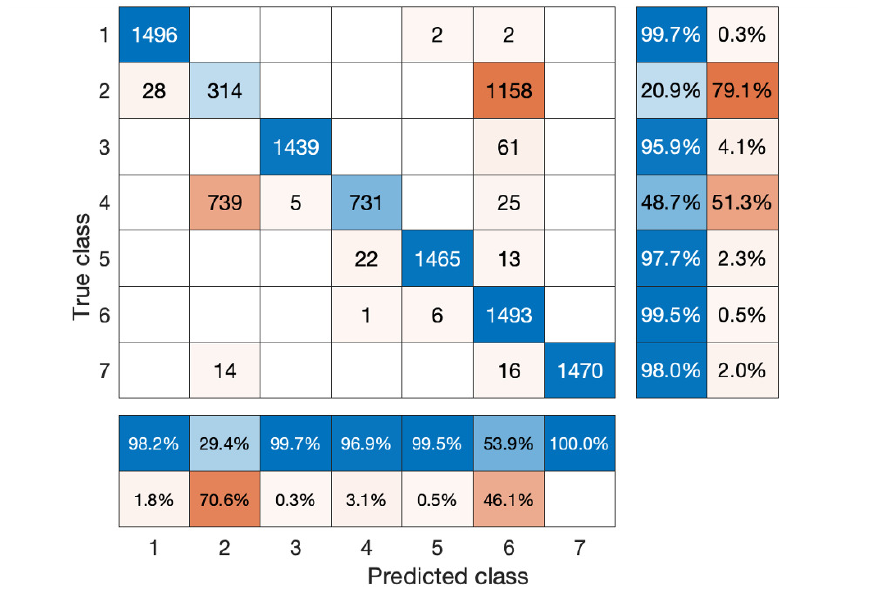
Figure 12. Confusion matrix for combining 3 sensor outputs, no. of hidden units = 50, and Σ